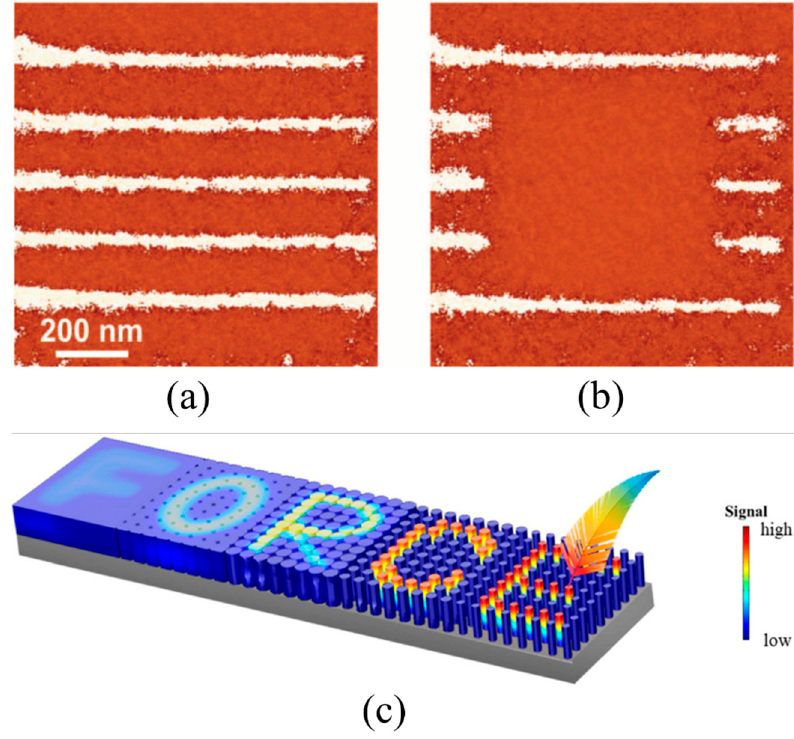
Figure 20. ( a , b ) Fabrication of nanoscale domain patterns using the tip of an atomic force microscope (AFM). Reprinted with permission from [74]. Copyright 2012 American Association for the Advancement of Science. ( a ) Domain lines were mechanically written on a BaTiO 3 film by scanning the film using the tip under a loading force of 1500 nN. ( b ) The same domain structure was modified by the electrical erasure of the mechanically written domains. The erasure was performed by scanning the central segment using the tip under a dc –3 V bias. ( c ) Scheme of the signal of force-induced devices on different surfaces with nanodots. Reprinted with permission from [99]. Copyright